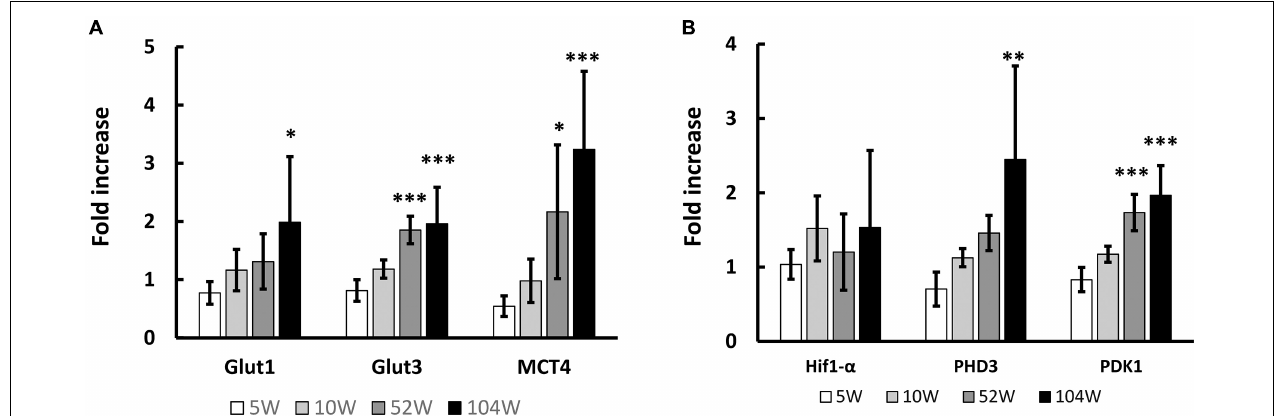
FIGURE 1 | Change in RNA transcription in circulating WBC with aging. (A) Significant increase of RNA transcription of energy source transport genes, including Glut1, Glut3 and MCT4, in WBC was observed with aging. (B) Similarly, RNA transcriptions of Hif1- α down-stream genes, PHD3 and PDK1, in WBC significantly increased with aging. ∗ p < 0.05, ∗∗ p < 0.01, ∗∗∗ p < 0.001 by ANOVA followed by post-hoc analysis using Dunnett test (versus 5W). N = 5 in 10W, 104W and N = 6 in 5W, 52W (A,B)